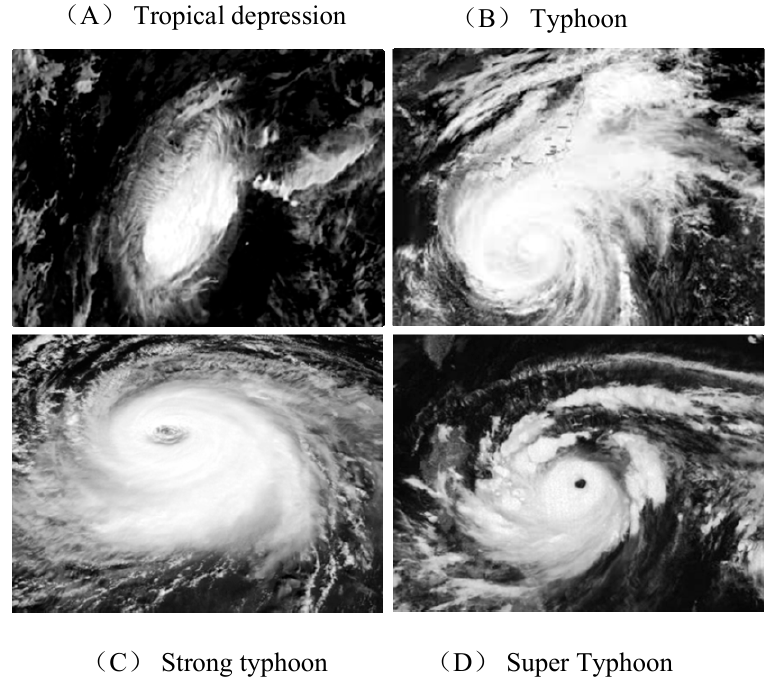
Figure 2. Some meteorological satellite cloud picture samples. Please add explanation of subfigures in